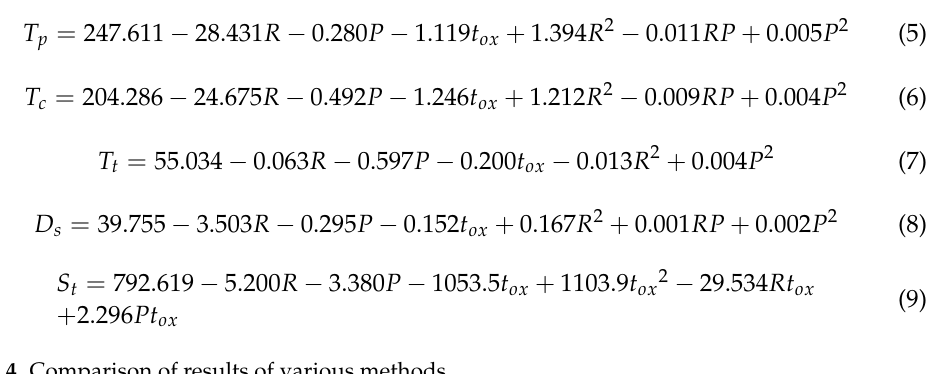
Table 4. Comparison of results of various